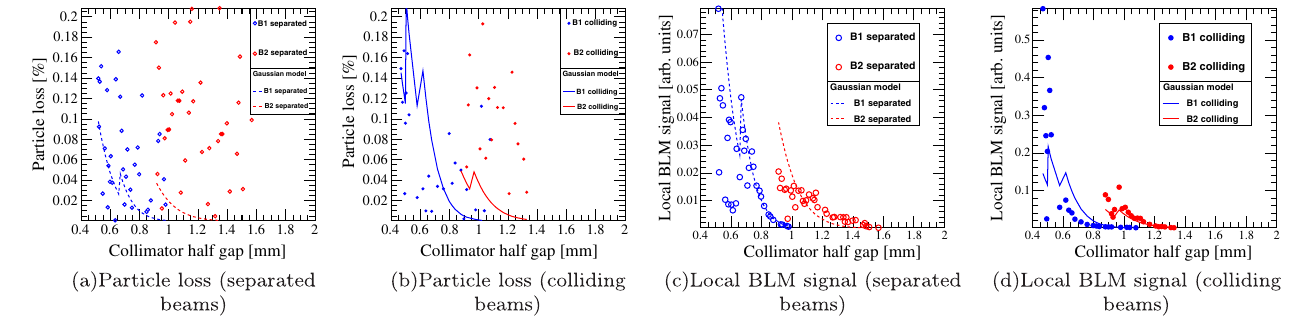
FIG. 8. Particle loss as a percentage of the intensity measured before the loss spike [parts (a) and (b)] and local BLM signal [parts (c) and (d)], with comparison to the static beam distribution at the start of scraping. The discontinuities in the static distribution curves are due to different jaw step sizes being used throughout the beam